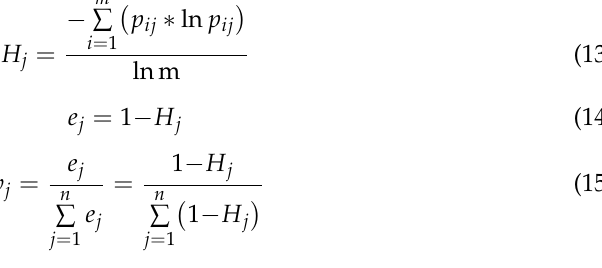
Table 10. Calculation results of the entropy